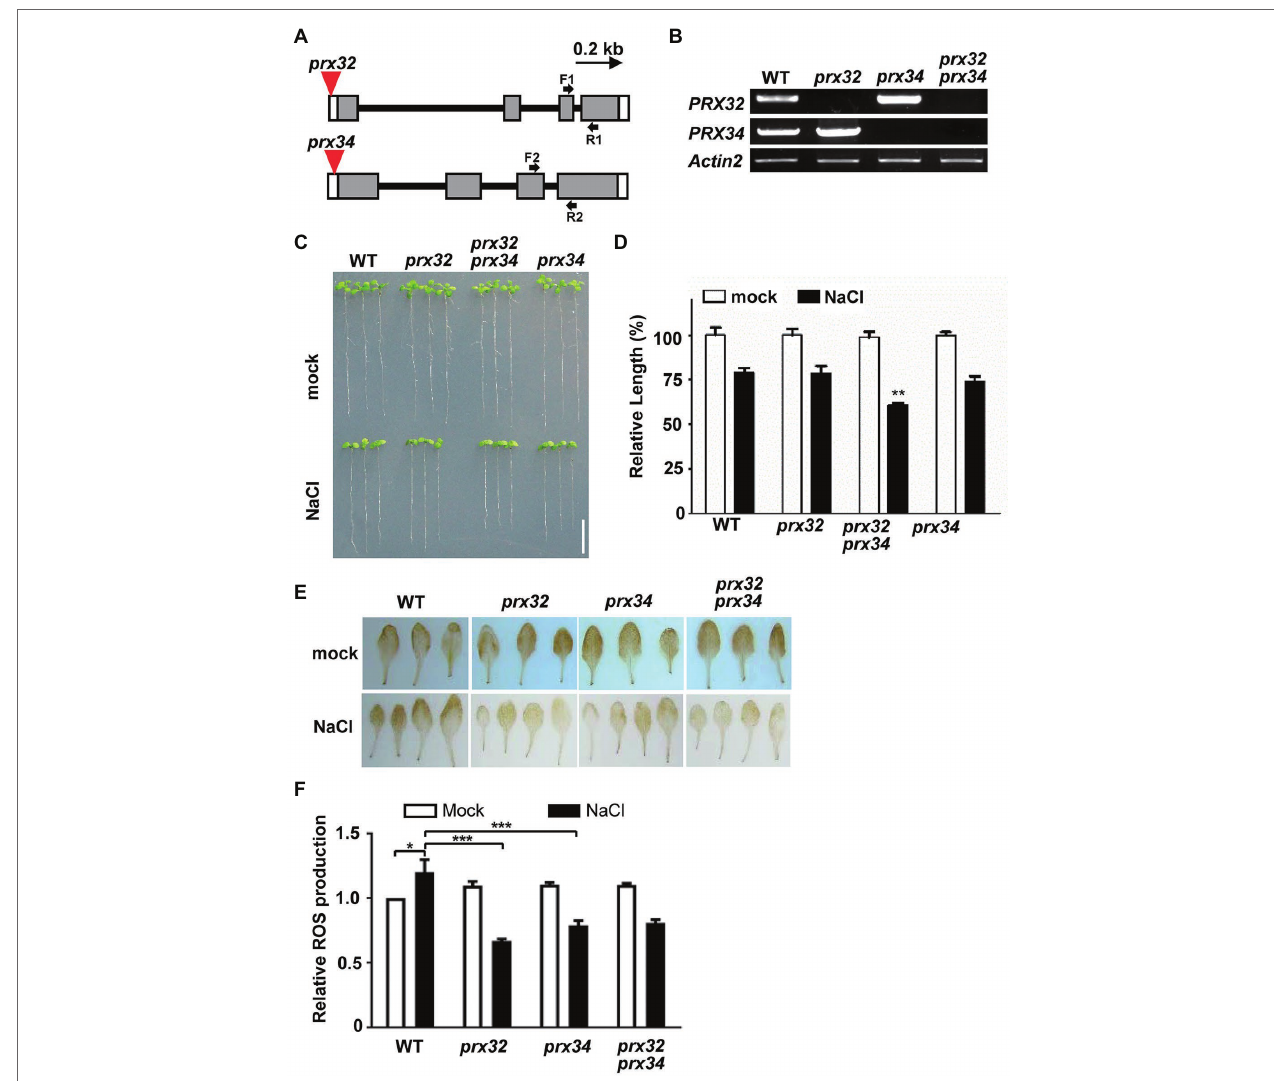
FIGURE 6 | PRX32 and PRX34 are required for root growth under salt stress. (A) T-DNA insertion sites of prx alleles. Gray boxes represent exons and are linked with introns (lines). The open boxes denote untranslated regions (UTR). The location of the T-DNA insertion site in each mutant line is marked as a red triangle. A bar with an arrow from 5 ' to 3 ' representing 0.2 kb length is shown. (B) Reverse transcription-PCR (RT-PCR) analyses of PRX32 and PRX34 gene expression. Two- week-old Arabidopsis seedlings were used for RNA extraction, and the transcript of Actin2 was amplified as an internal control. (C) Root growth phenotypes against salt treatment. Five-day-old seedlings were transferred to MS medium supplemented without (mock) or NaCl to grow for 9 days before taking photos. Bar = 0.5 cm. (D) Statistics analysis of root length. The root length shown in (C) was statistically analyzed. The primary root length of the WT (mock) was set as 100%, and relative values were shown. **Indicated a significant difference from the value of the WT (NaCl) with p < 0.001, n > 20 (Student’s t -test). (E) Reactive oxygen species (ROS) production analysis by 3,3 ' -Diaminobenzidine (DAB) staining. Two-week-old seedlings were transferred to liquid Murashige and Skoog (MS) medium supplemented without (mock) or 200 mM NaCl to grow for 6 h before staining. (F) Statistics analysis of DAB staining. The measurement was performed in ImageJ software. The value of WT (mock) was set as 1.0, and relative values were shown. * and *** indicated significant differences at p < 0.01 and p < 0.0001, respectively (both n > 10, Student’s t